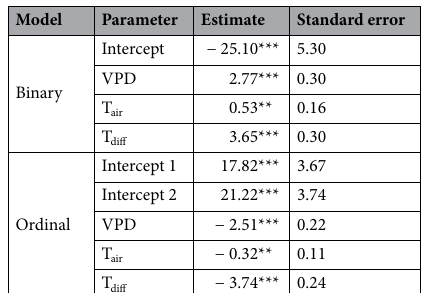
Table 2. Logistic model parameters. Asterisks indicate the parameter significantly different from 0. ** p < 0.01, *** p < 0.001.